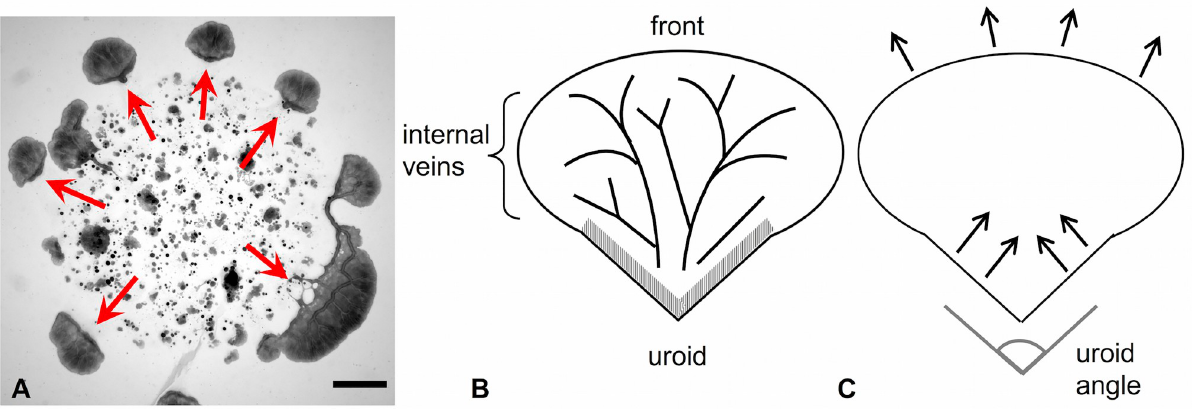
Fig 1. Mesoplasmodia migration pattern and schematic drawing. A) Mesoplasmodia emerging from microplasmodia plated on glucose-deficient agar. Image taken 7 hours after plating. Arrows indicate star-shaped migration pattern. Scale bar = 2 mm. B) and C) Schematic representation of a mesoplasmodium. B) The three most important regions involved in locomotion: the uroid (hatched area), internal veins, and front. An explanation is provided in the text. C) Proposed mechanism of the amoeboid locomotion employed by mesoplasmodia. Contractions are generated in the uroid, whose shape (uroid angle) influences locomotion speed. The front is pushed outwards passively by the flow.